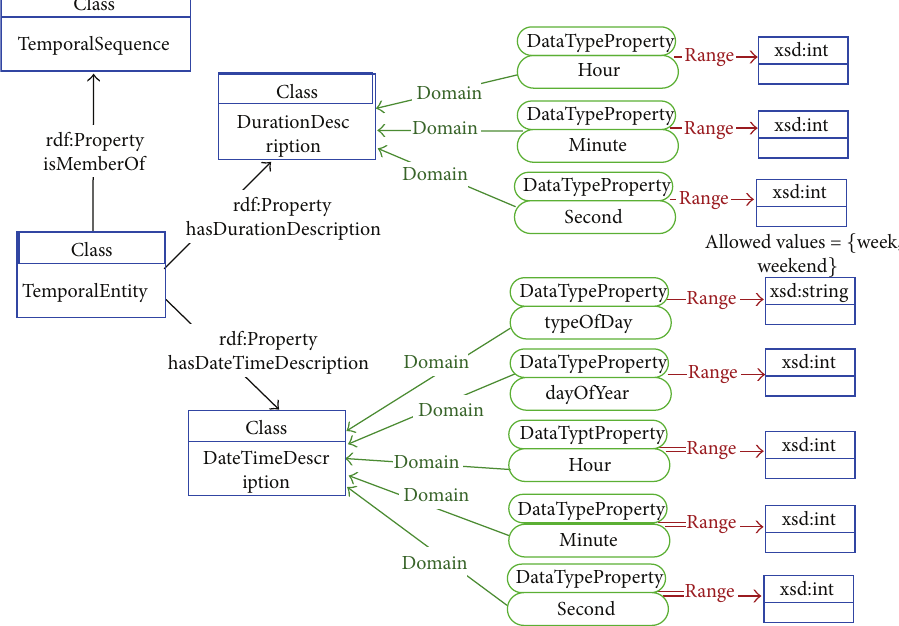
Figure 4: Conceptual diagram of the temporal information associated with the physical activity.